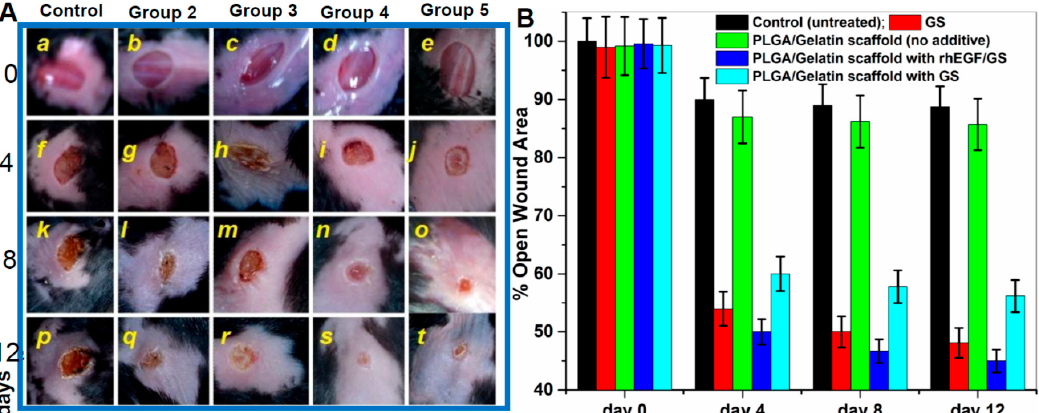
Figure 6. In vivo wound healing assay in mouse model. ( A ) Wound Healing in Diabetic C57/BL6 Mice after Treatment with Various Electrospun Nanofibrous Scaffolds (Batch 1) [a–t represent the extent of wound healing during 12 days period] Group 1—No treatment (negative control) ; Group 2—0.1% gentamicin sulfate ointment (positive control) ; Group 3—PLGA/Gelatin 70:30 scaffold without gentamicin sulfate and rhEGF ; Group 4—PLGA/Gelatin 70:30 scaffold with gentamicin sulfate and rhEGF ; Group 5—PLGA/Gelatin 70:30 scaffold with gentamicin sulfate and without rhEGF. ( B ) Open wound area (% of initial area) over 12 days for each treatment group from control and three experimental groups performed from five different wound healing assays. The results are expressed as the median ± standard deviation from five independent experiments performed in triplicate (n = 5).